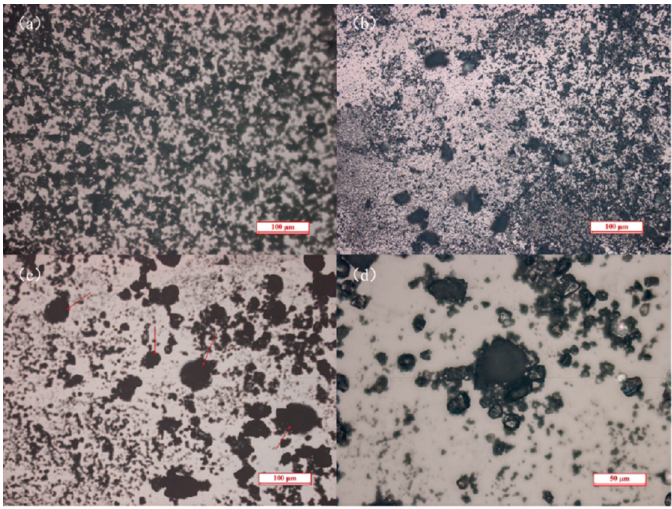
Figure 11. Microscope images of fine ilmenite treated with/without HGB. ( a ) Ilmenite, ( b ) ilmenite + NaOL, and ( c , d ) ilmenite + NaOL + HGB. (The mineral size distributions of 0–19 µm, pH = 6.0, 4.0 × 10 –4 mol·L –1 sodium oleate.)